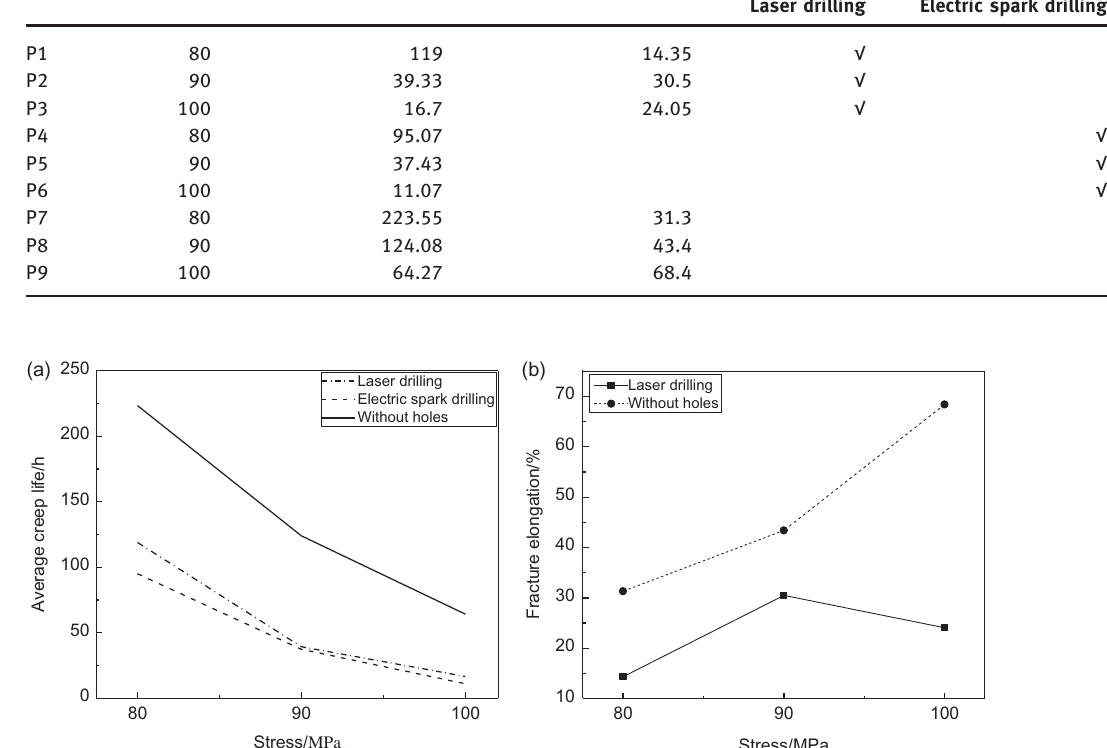
Table 2: Creep properties of plate specimens under different applied stresses at 850 ℃ . No. Stress/MPa Average creep life/h Fracture elongation/% Multi-inclined holes Laser drilling Electric spark drilling Without